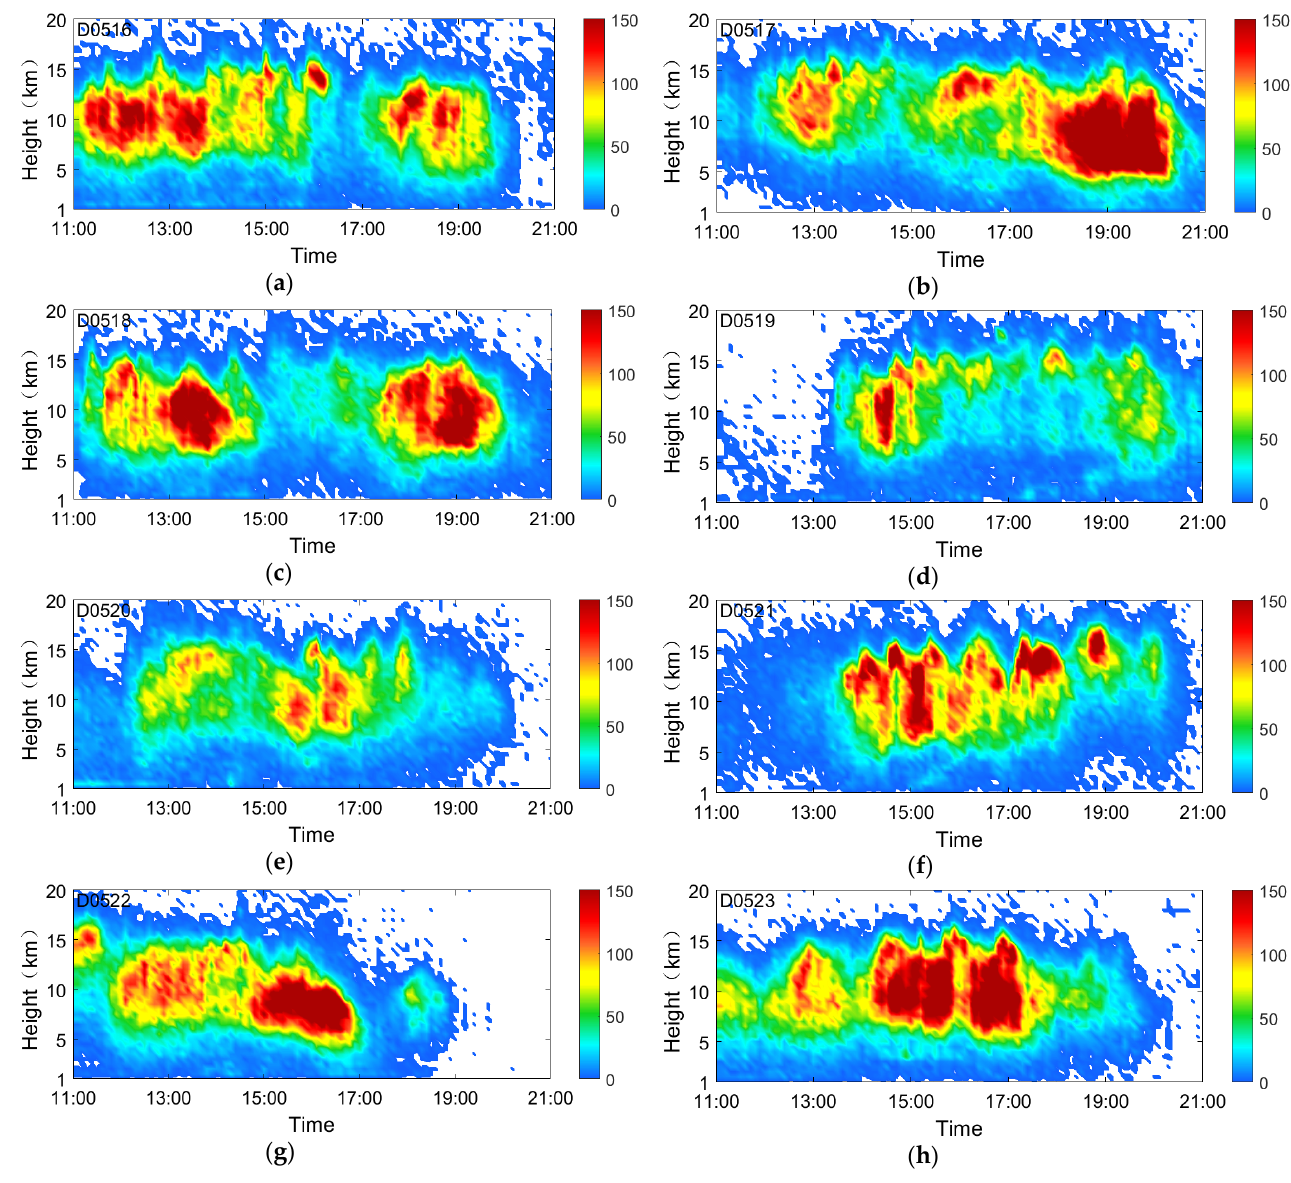
Figure 3. Overview of height distribution and number in eight days: ( a – h ) IC events data from 11:00 to 21:00, colored by frequency. The color scale of lightning frequency is qualitative, with red being most events and blue least.